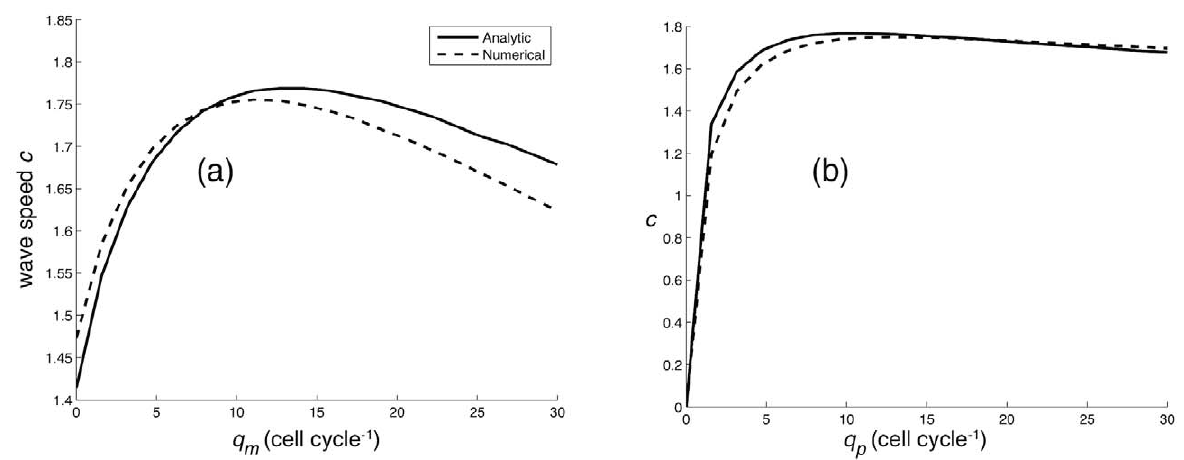
Figure 5. Comparison between continuum model and analytical result. The wave speed of the propagating tumour margin determined from both phase space analysis (solid line) and numerical simulation (dashed line). In (a) the switch rate to proliferation is fixed at q p ~ 22 , while in (b) we have fixed q m ~ 6 : 3 .